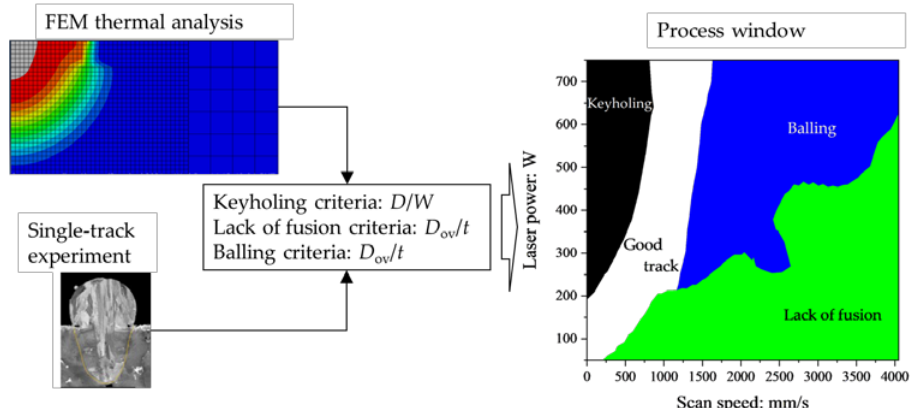
Figure 2. A workflow to generate the process window using the results from FEM simulation and single-track experiment.